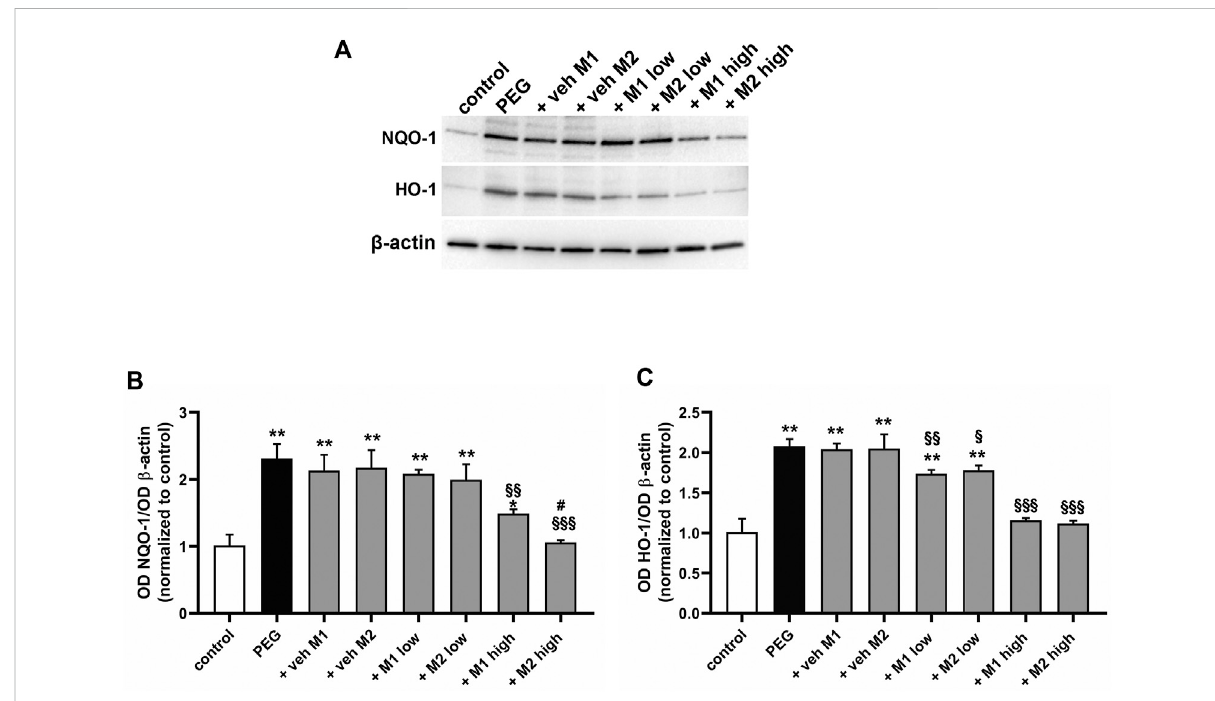
FIGURE 1 Effect of M1 and M2 on oxidative stress markers. Representative Western blots (A) and densitometric analysis of NQO-1 (B) and HO-1 (C) in controls, PEG-injected untreated,PEG-injectedtreated with M1orM2vehicles,PEG-injectedtreated withlow orhighdoseof M1as wellas with low or high-dose of M2. β -actin was used as loading control. Data are plotted as mean ± SEM. Differences among groups were tested using one-way ANOVA followed by Tukey ’ s multiple comparison post-hoc test (N = 6). * p < 0.01 and ** p < 0.001 vs. control; § p < 0.05, §§ p < 0.01 and §§§ p < 0.001 vs. respective vehicle; # p < 0.05 vs. M1